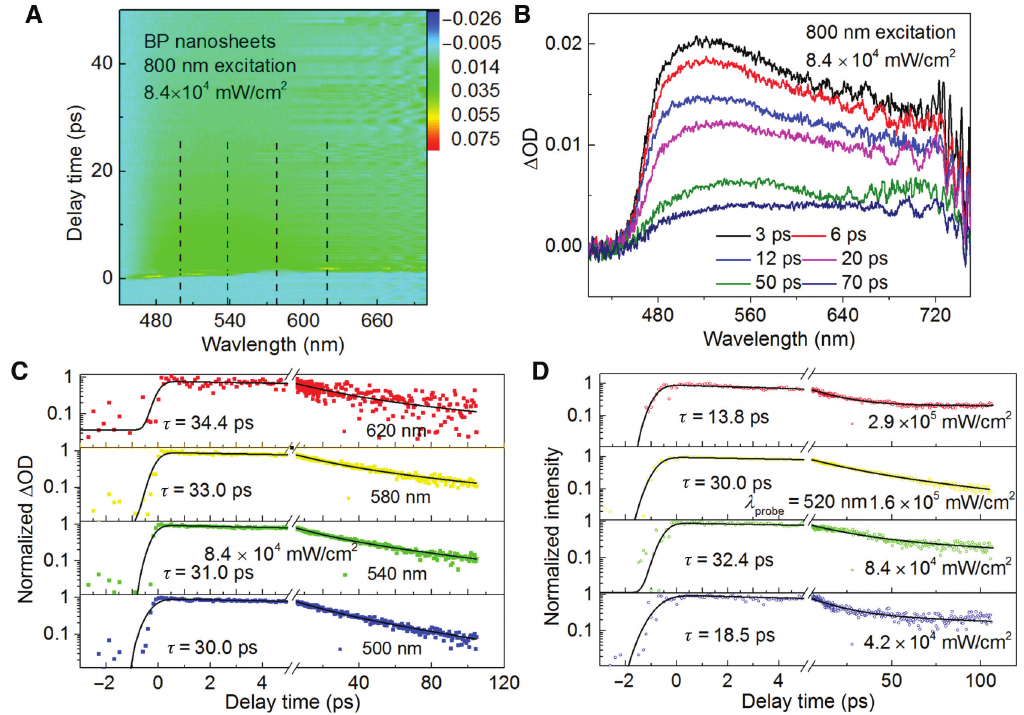
Figure 4: Wavelength and fluence dependent ultrafast carrier dynamics of BP nanosheets with pump wavelength at 800 nm. (A) Two-dimensional (2D) mapping of transient absorption (TA) spectrum for black phosphorus (BP) nanosheets pumped at 800 nm with the pump fluence at 8.4 × 10 4 mW/cm 2 . (B) Spectra of change of optical density at different delay times. (C) Carrier dynamics (at 800 nm pump) at different probe wavelengths with pump fluence fixed at 8.4 × 10 4 mW/cm 2 . (D) Carrier dynamics at different pump (at 800 nm) fluences from 4.2 × 10 4 mW/cm 2 to 2.9 × 10 5 mW/cm 2 with probe wavelength fixed at 520